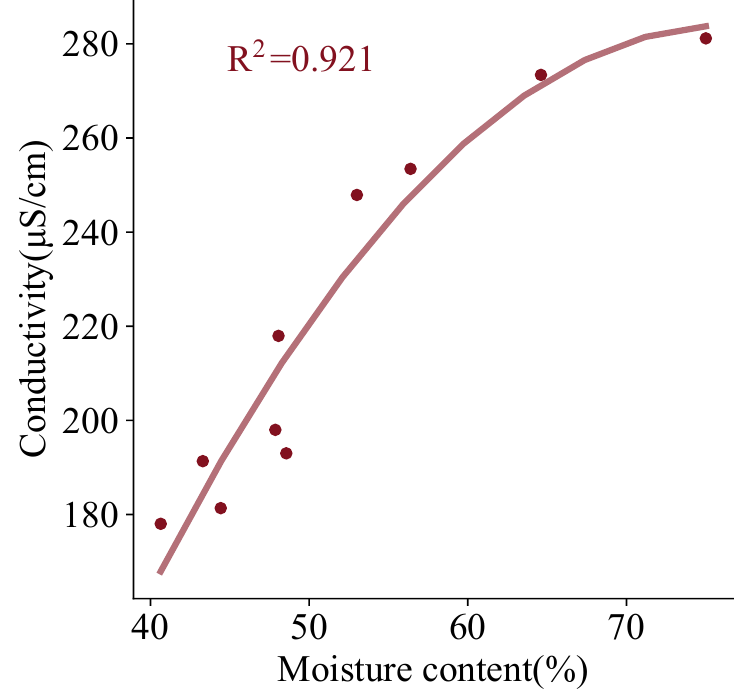
Figure 12. Relationship between conductivity and moisture